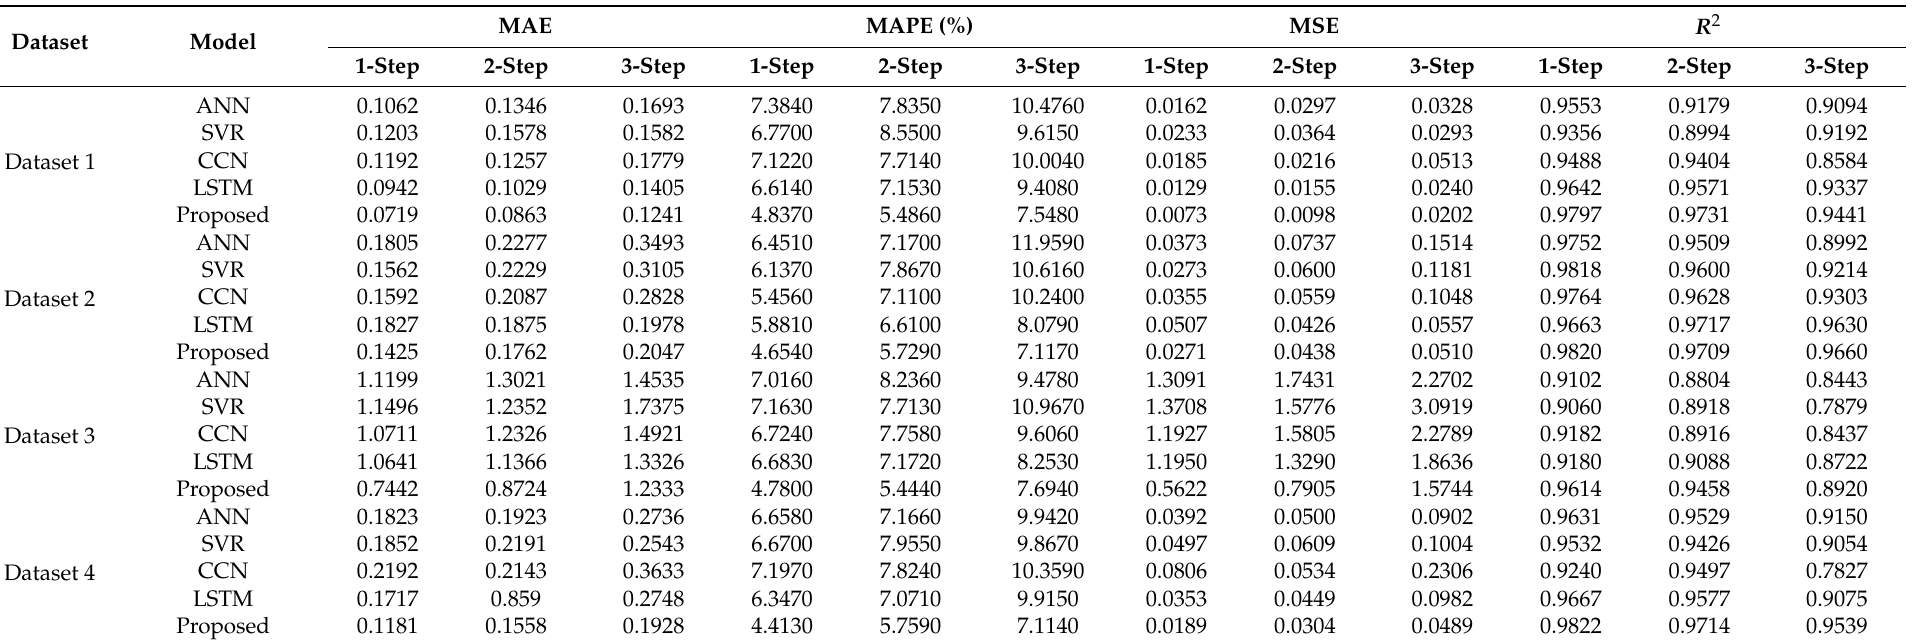
Table 7. Error evaluation results of SSA-CCN-ATT and other individual models in four